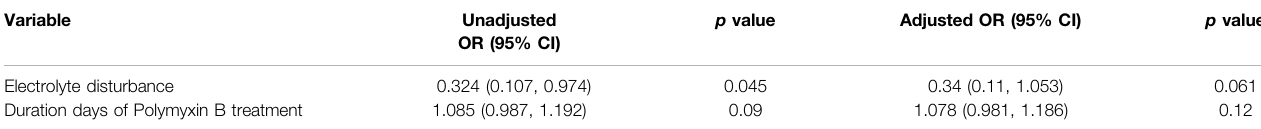
TABLE 3 | Univariable and multivariable logistic regression analysis of a favorable clinical outcome.